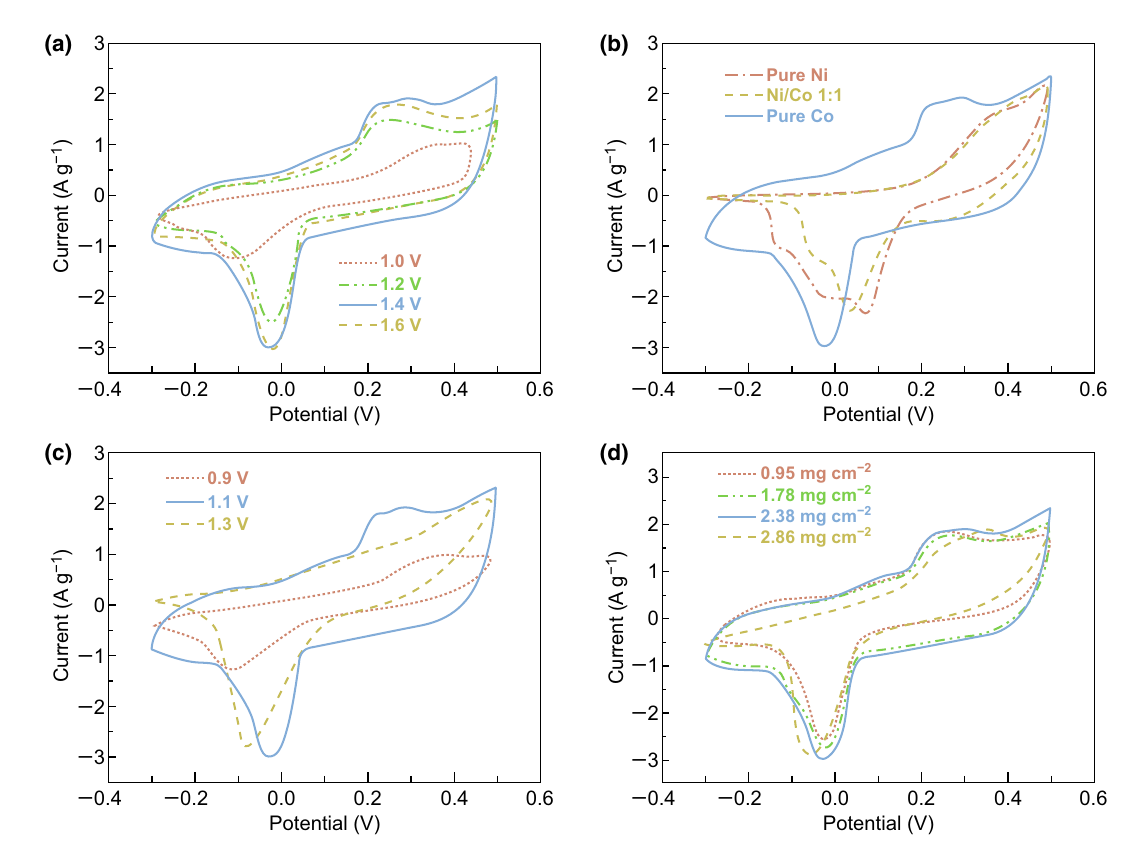
Fig. 4 CV curves of a the electrodes with nickel layers electrodeposited at different voltages, b phosphides fabricated by different Ni/Co ratios, c CoP fabricated on Ni NTAs@SE at different voltages, d different CoP mass loadings on Ni NTAs@SE at a scanning voltage rate of 20 mV s −1